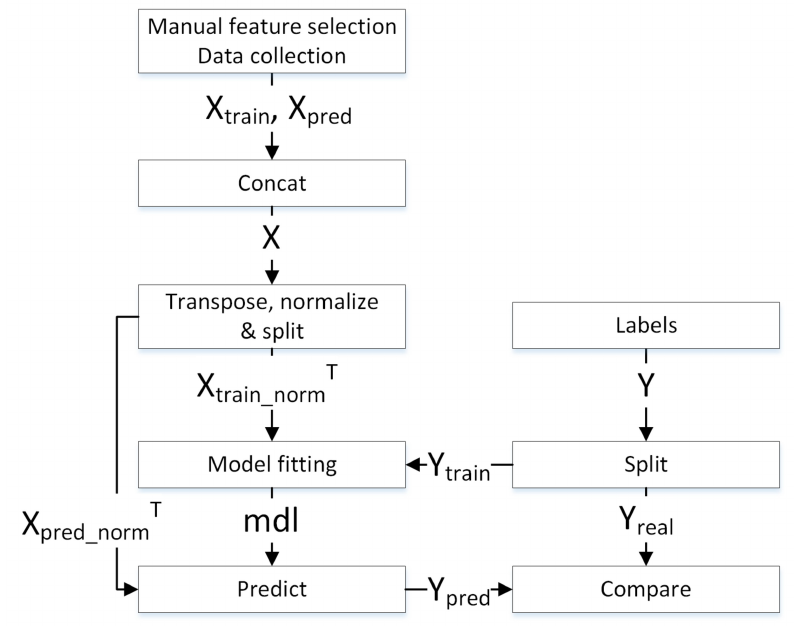
Figure 3. Data flows for training the machine learning model and using it to make